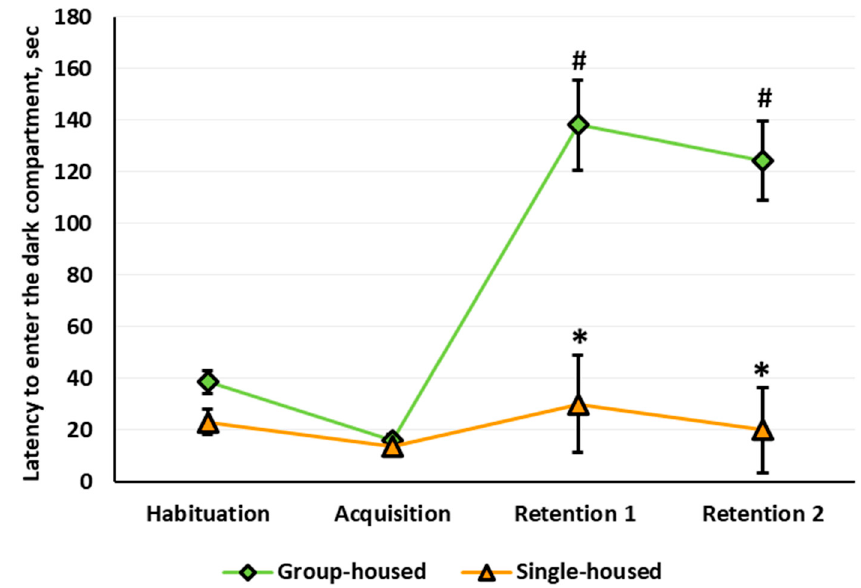
Figure 8. The latency to enter the dark compartment of the arena (sec) in the passive avoidance paradigm. The # indicates a statistically significant difference compared with the group-housed rats at the Habituation stage, p < 0.001; the * indicates p < 0.001 compared with the group-housed rats at the same stage of the experiment (ANOVA followed by the Newman–Keuls post hoc test). See Supplementary Materials, Tables S12.